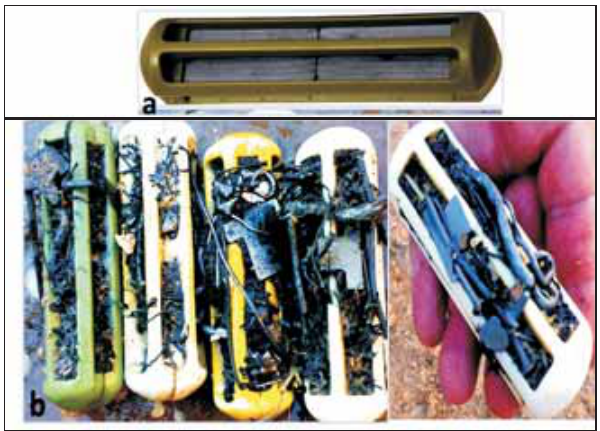
Figure-1: (a): New rumen magnet, (b) Trapped metallic foreign bodies on retrieved magnets after rumenotomy in buffaloes. Table-1: Total number of examined, discarded, followed up and hardware diseased buffaloes Numbers of